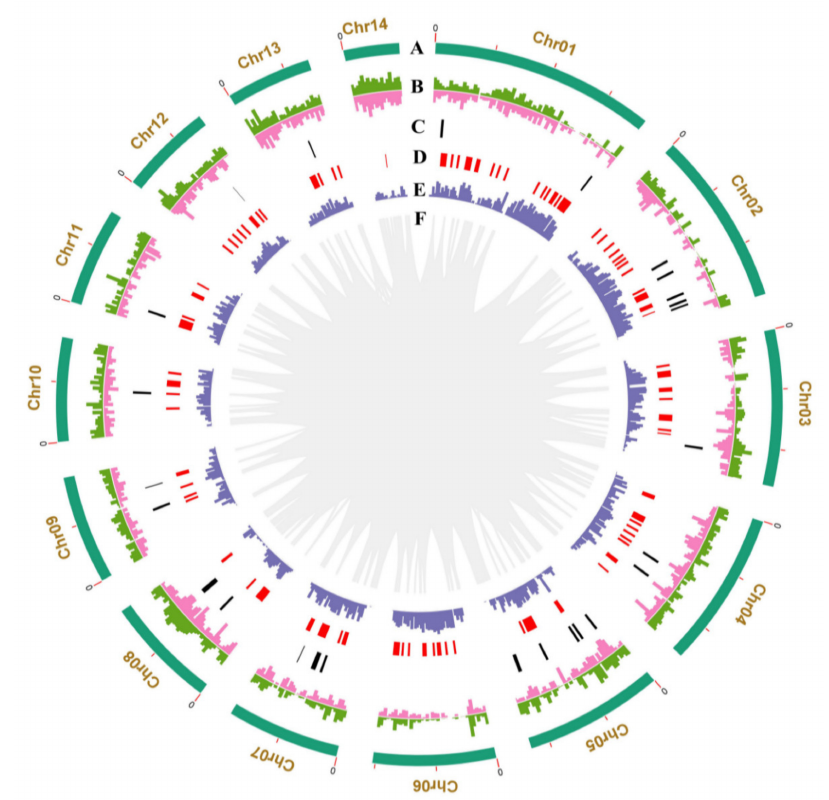
Figure 1. Circos graph of genome characteristics of Wolfiporia hoelen . ( A ) 14 pseudo-chromosomes; ( B ) Transposable elements (TEs) of which transposons are in green and retrotransposons in pink; ( C ) Clusters of secondary metabolites; ( D ) Non-coding RNA (ncRNA); ( E ) Gene density; ( F ) Large fragment duplication (>10